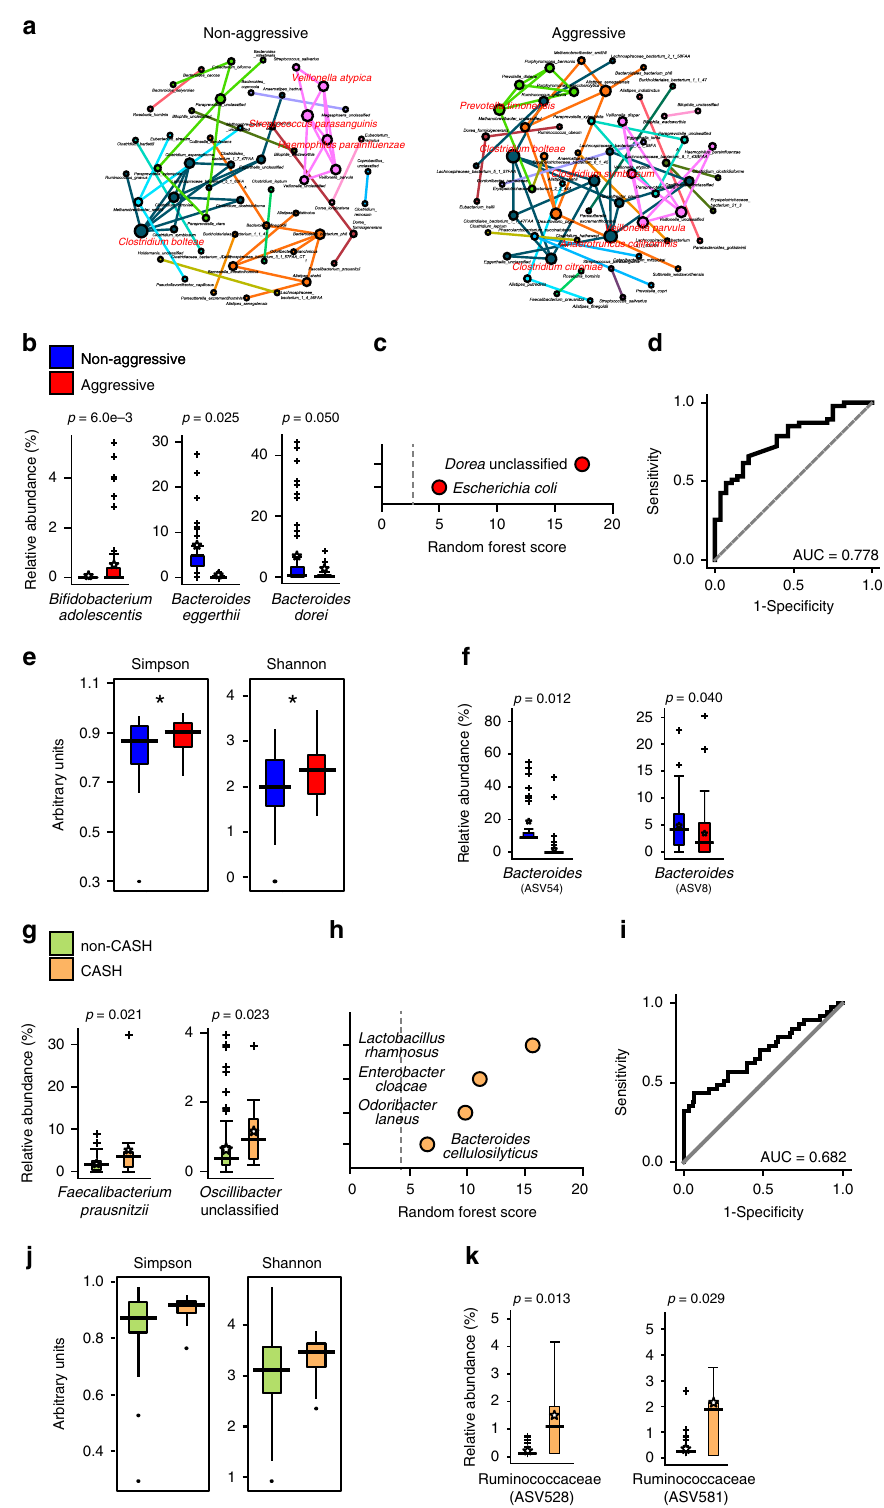
Of the three species identi fi ed in the diagnostic microbiome (Fig. 1e, f), F. prausnitzii and B. adolescentis are Gram-positive species have been shown to be protective against gut in fl amma- tion 28 – 30 , and are less abundant in CA patients. The Gram- negative species O. splanchnicus , more abundant in CA patients, enhances gut in fl ammation, and has been linked to other neu- rological diseases 31 . Other species identi fi ed by multi-variate